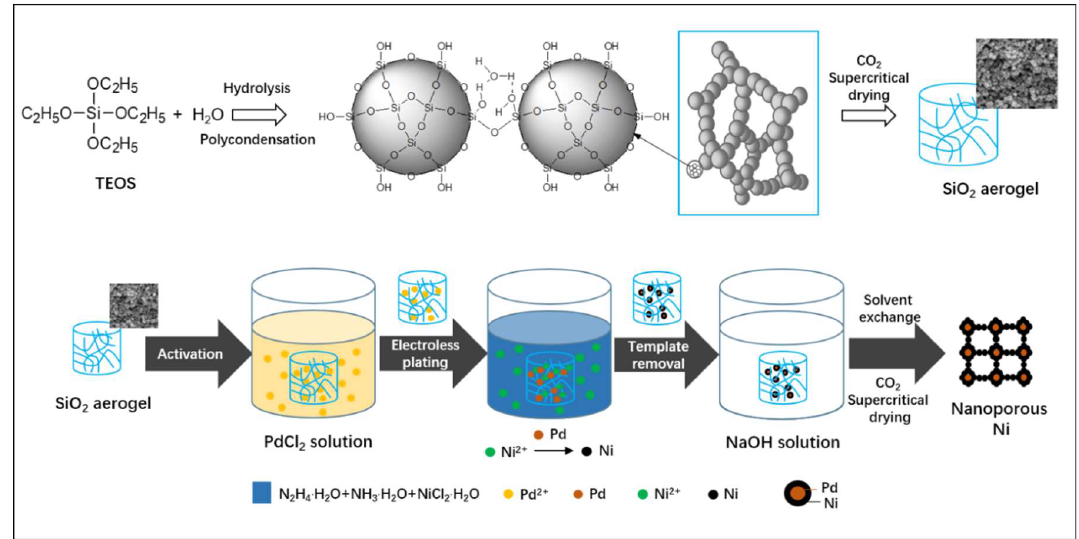
Figure 1. Schematic illustration for fabrication of SiO 2 aerogel and nanoporous Ni.